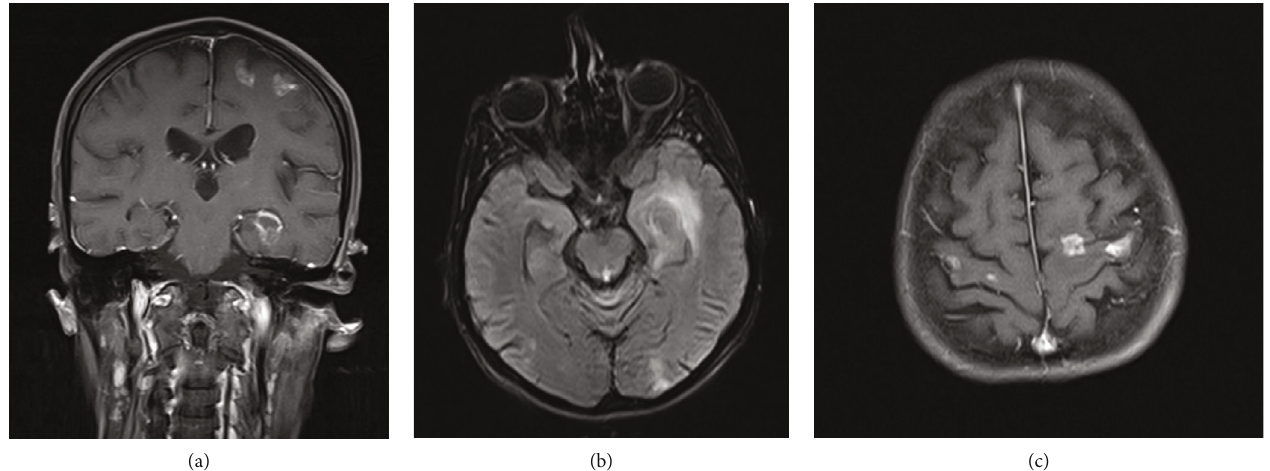
Figure 2: Magnetic resonance imaging (MRI): T1 with contrast in coronal (a) and axial planes (b, c): multiple ring-enhancing lesions in the left and right cerebral cortices.